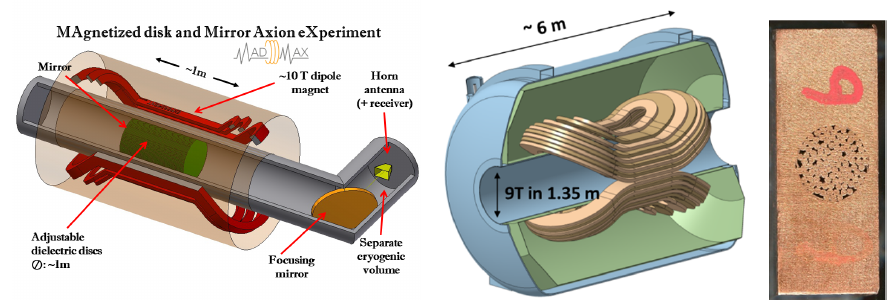
Figure 2. Left: Sketch of M admax baseline design. Center: Drawing of the planned M admax magnet configuration. Right: CICC supeconductor cross section after